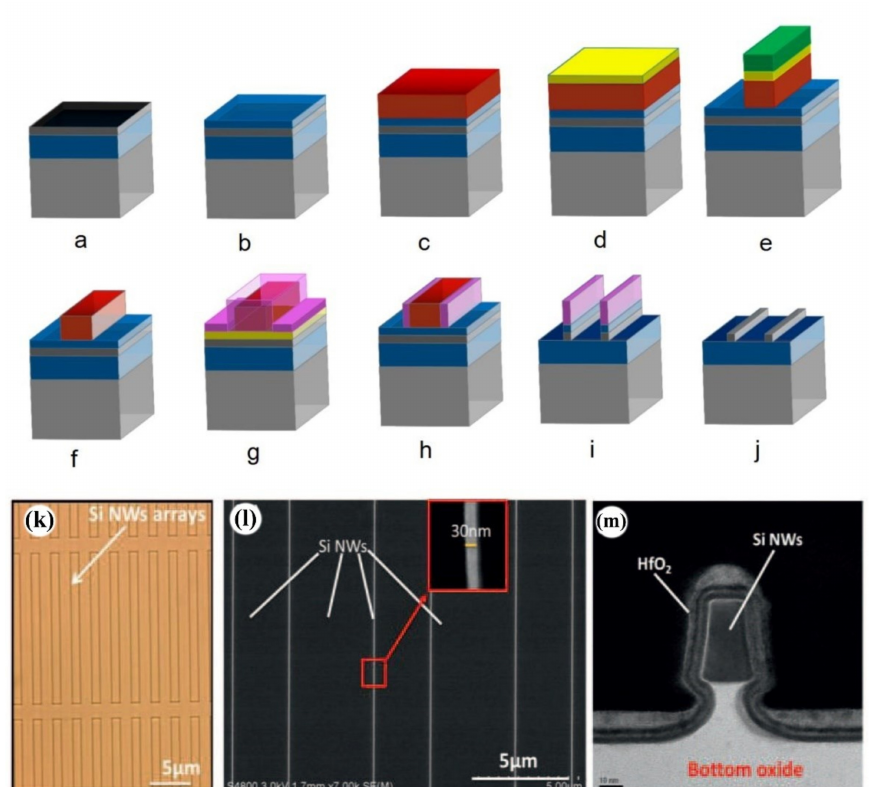
Figure 2. Process flow of Side-wall Transfer Lithography (STL). ( a ) SOI substrate ( b ) Oxide deposition (PEOX) on SOI, ( c ) amorphous-Si ( α -Si) on PEOX, ( d ) SiN hardmask, ( e ) lithography & etch of hardmask and dummy gate, ( f ) stripe photoresist and SiN, ( g ) SiN deposit on etched α -Si, ( h ) etch spacer, ( i ) etch Si-NW, ( j ) remove α -Si and PEOX then Si-NWs are formed. Fabrication of Si NWs sensor: ( k ) top view of Si NW arrays by optical microscope, the length of NWs is about 50 µ m. ( l ) SEM image of Si NW arrays, the NWs width is about 30 nm, ( m ) cross sectional TEM image of Si NW sensors, conformal and uniform HfO 2 layer are observed, which is attributed to a good isolation between electrode and the solution of cells. Figure 2k–m are reproduced from [72], with permission from IEEE,